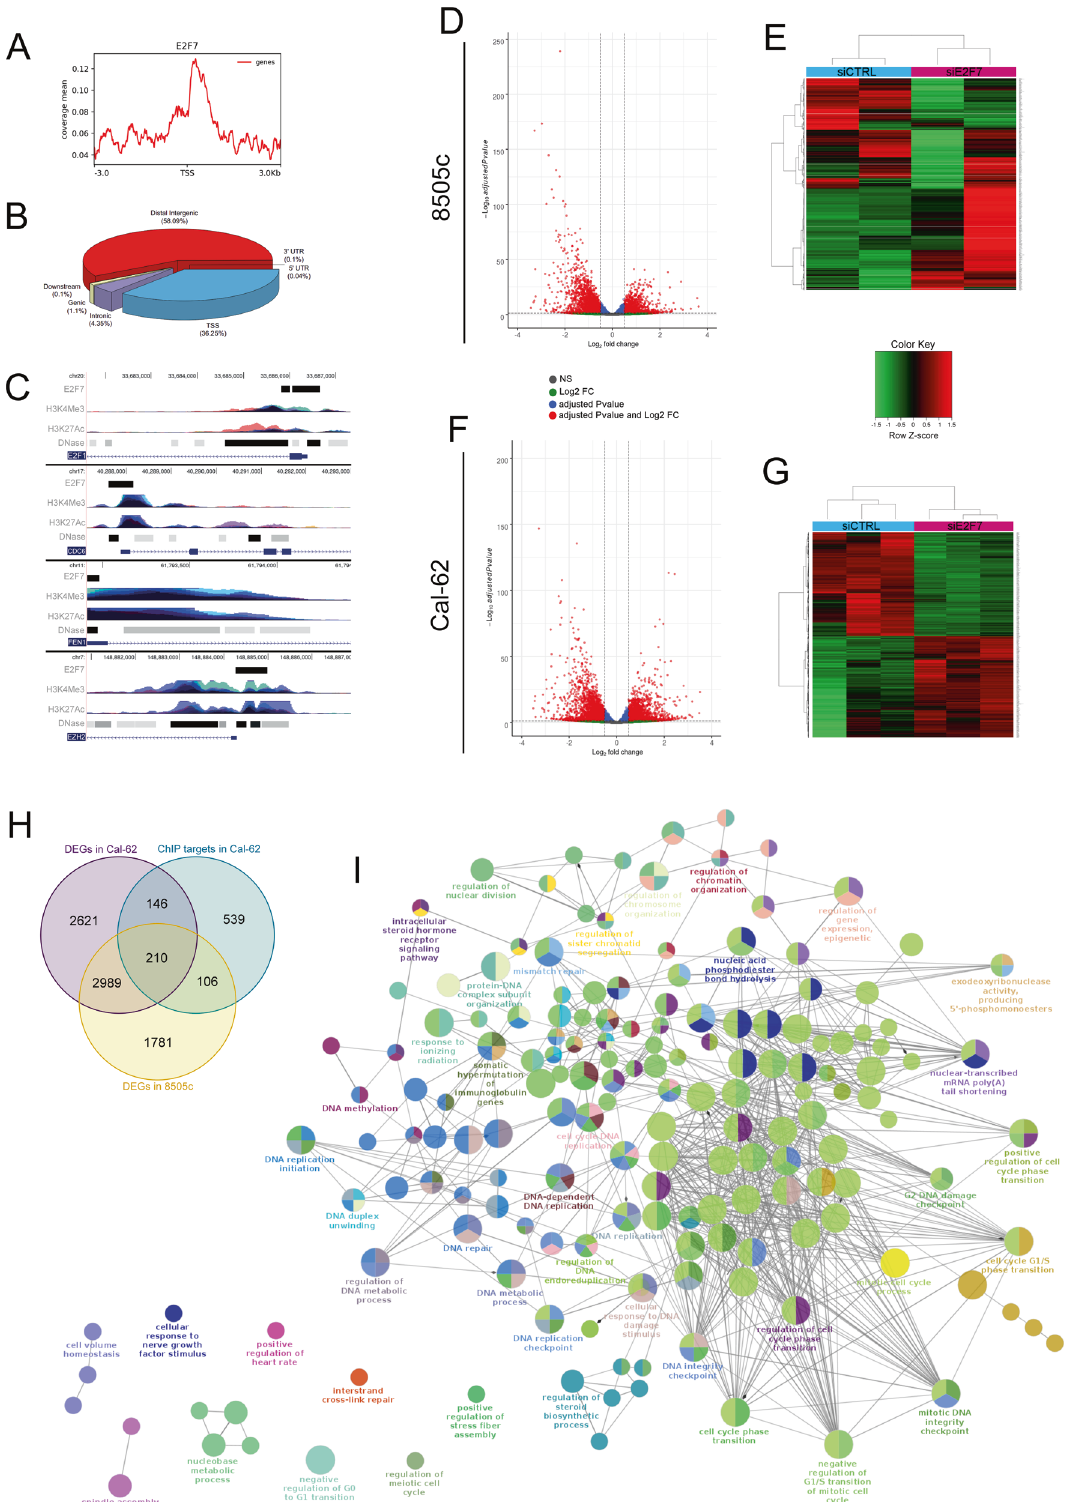
redundancy and/or compensation between E2F7 and E2F8 [14]. Even if E2F7 KD led to a signi fi cant increase in E2F8 expression (Fig. 5A, B), this cannot rescue the phenotype imposed by loss of E2F7, supporting a non-overlapping function of these factors in this